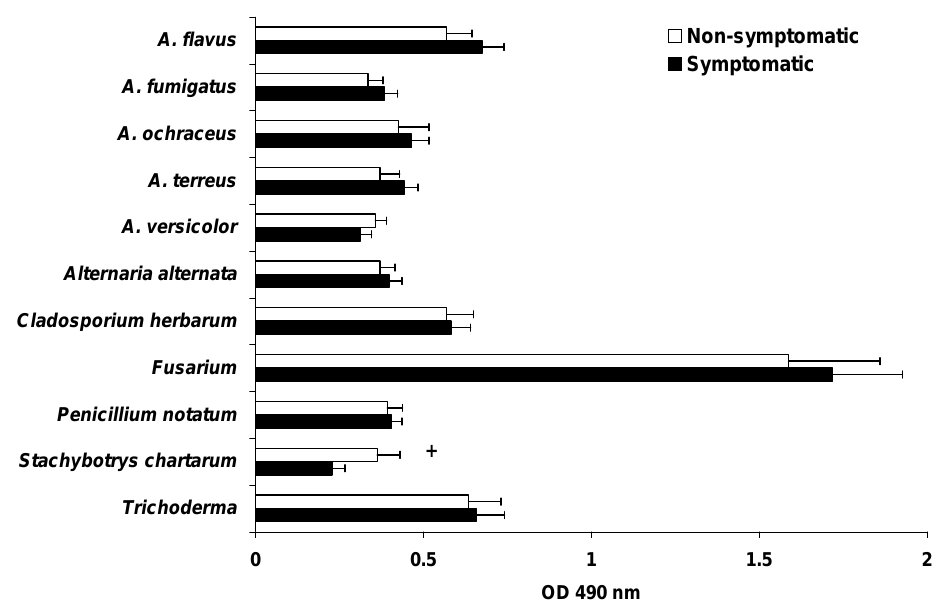
Figure 3. Levels of specific IgA antibodies to mold antigens are presented as OD values. Data are presented as mean ± SEM. The “ p ” value designated as +non-symptomatic vs. symptomatic <